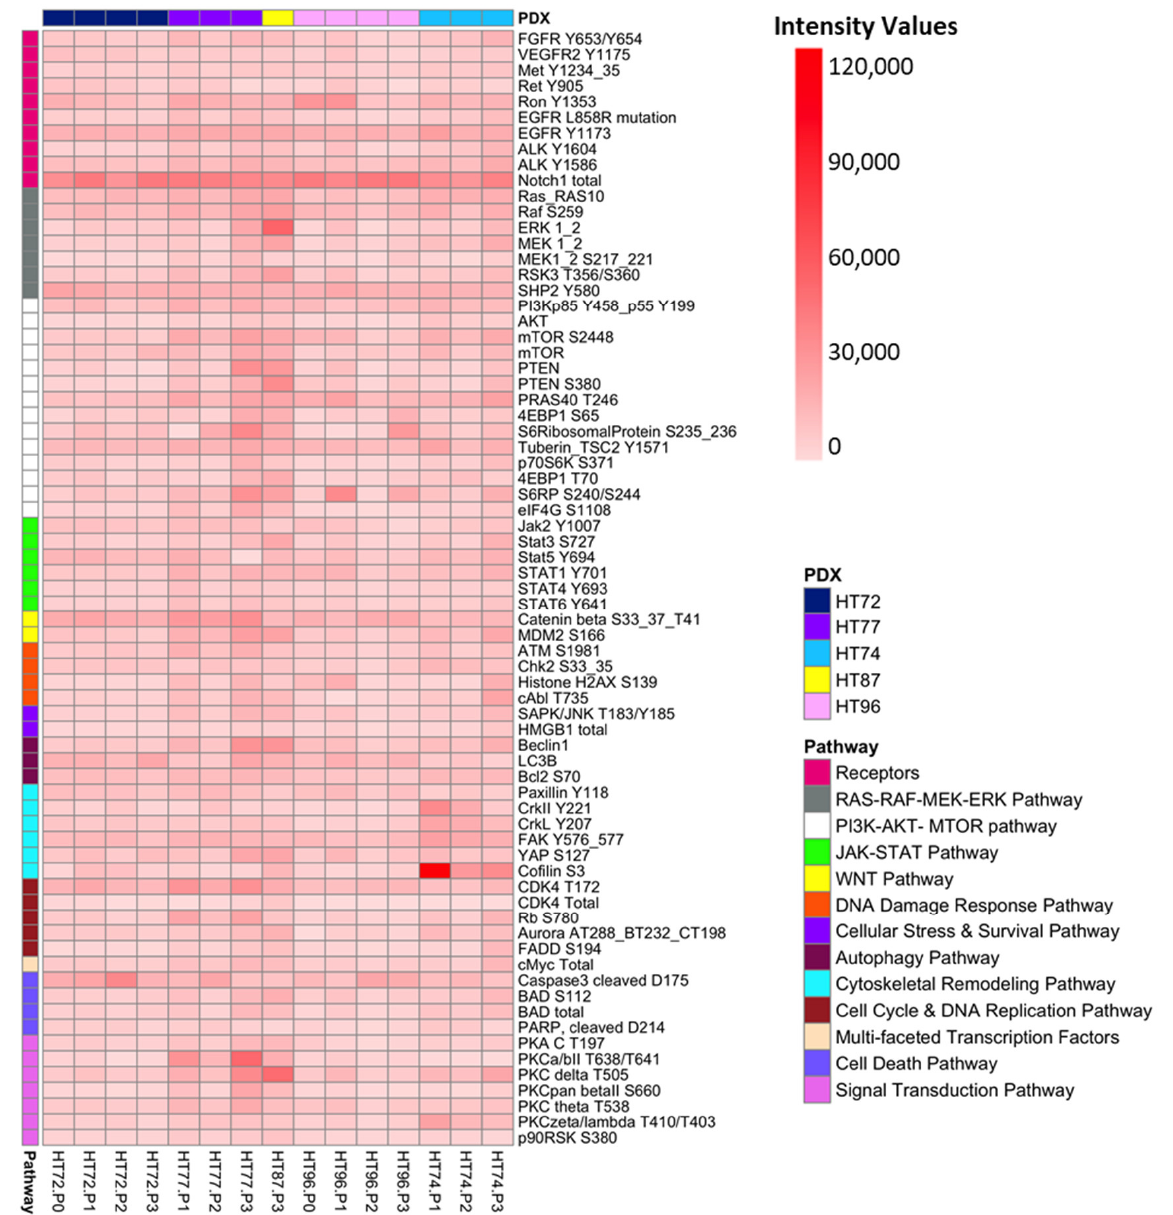
Figure 14. Integration of Western blot and RPPA data for OS. Expression of total and phosphopro- teins, as evident by either RPPA or Western blot analysis (refer to figure key), were used to map out a network of biological pathways that may contribute to disease pathogenesis. Some of the selected proteins, such as MYC, PTEN, Cyclin D, and H2AX, were cross-validated by Western blot. For example, COSMIC-associated CNV data indicated copy number gains/amplifications in MYC , RAD21 , Cyclin D3 , Cyclin E1 , as well as loss of CDKN2A and P53 genes that were then validated for corresponding proteins by Western blot and/or